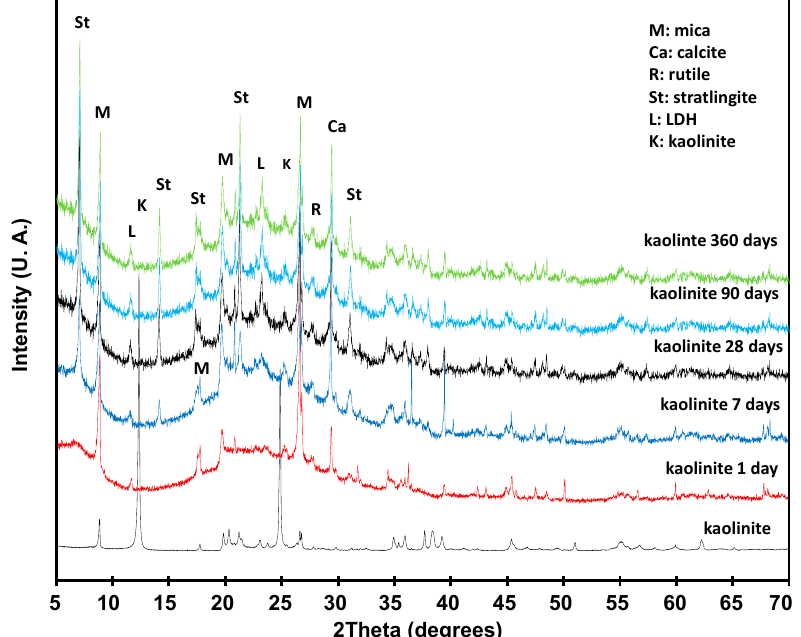
Figure 3. XRD patterns from kaolin / lime systems at one, seven, 28, 90, and 360 days of pozzolan reaction at 600 °C/2 h.